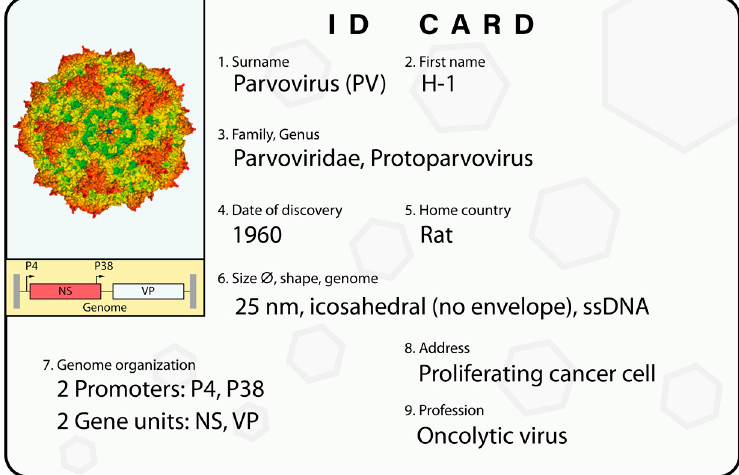
Figure 1. H-1PV’s ID card. An overview of H-1PV classification and main features. The virus genome is a single-stranded DNA (ssDNA) molecule including two promoters. The P4 promoter controls the nonstructural unit (NS), which encodes the NS1 and NS2 nonstructural proteins; and the P38 promoter regulates the expression of the VP gene unit, which encodes the VP1 and VP2 capsid proteins. At its extremities, the viral genome contains palindromic sequences (depicted in grey) that are important for virus DNA amplification. An in silico model of the virus capsid is shown [41]. See text for a more detailed description.